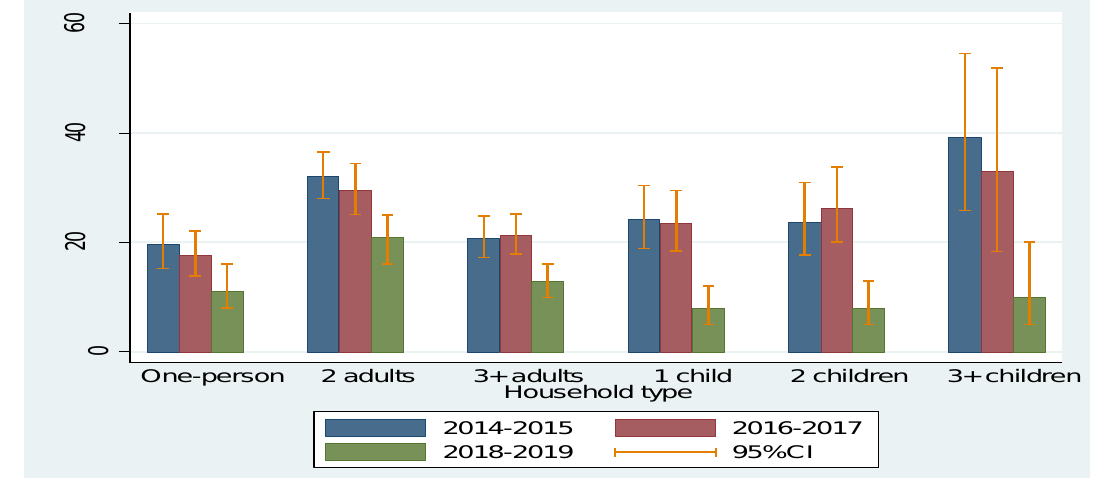
Figure 1. The prevalence of FI according to the household composition.